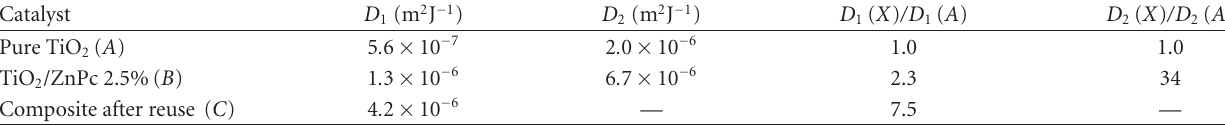
Table 1: Degradation constants ( D ) for LSA degradation under di ff erent conditions.